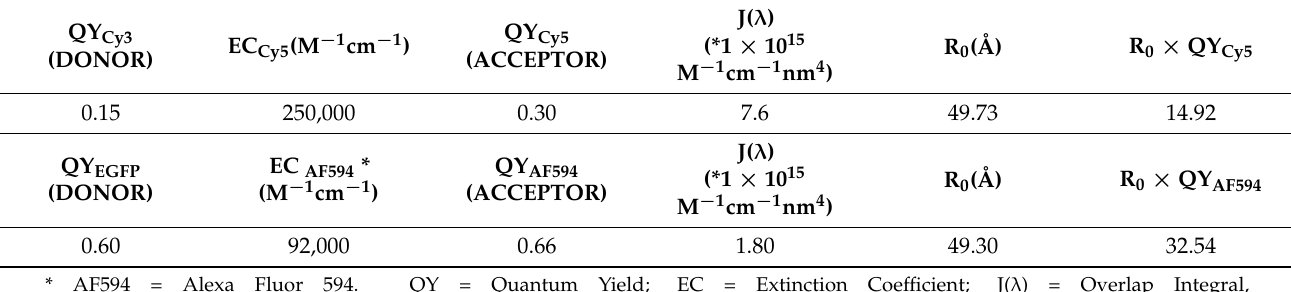
Table 2. Specification of donors and acceptors used for fluorescence lifetime image microscopy–Förster resonance energy transfer (FLIM-FRET)